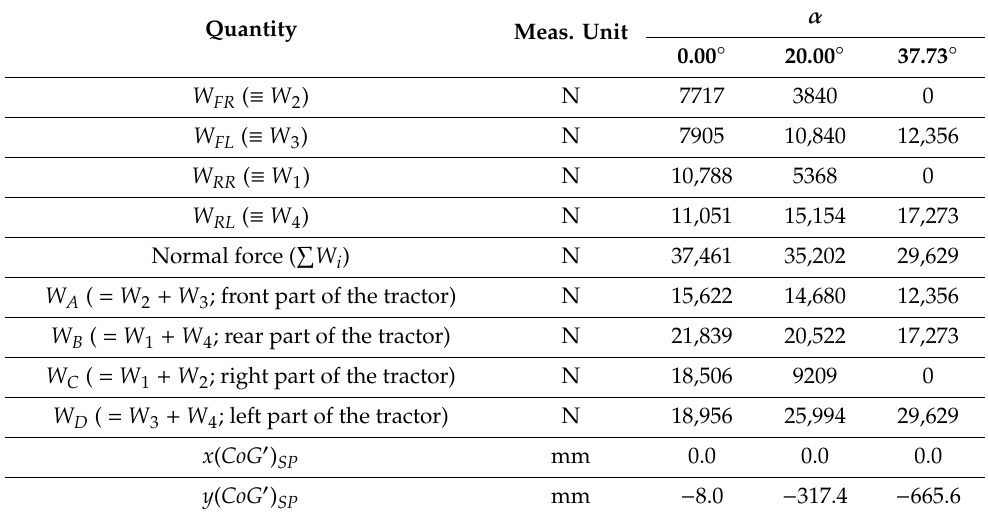
Table 4. Results from the simulated static test (at three di ff erent inclinations: 0.00 ◦ , 20.00 ◦ and 37.73 ◦ ).